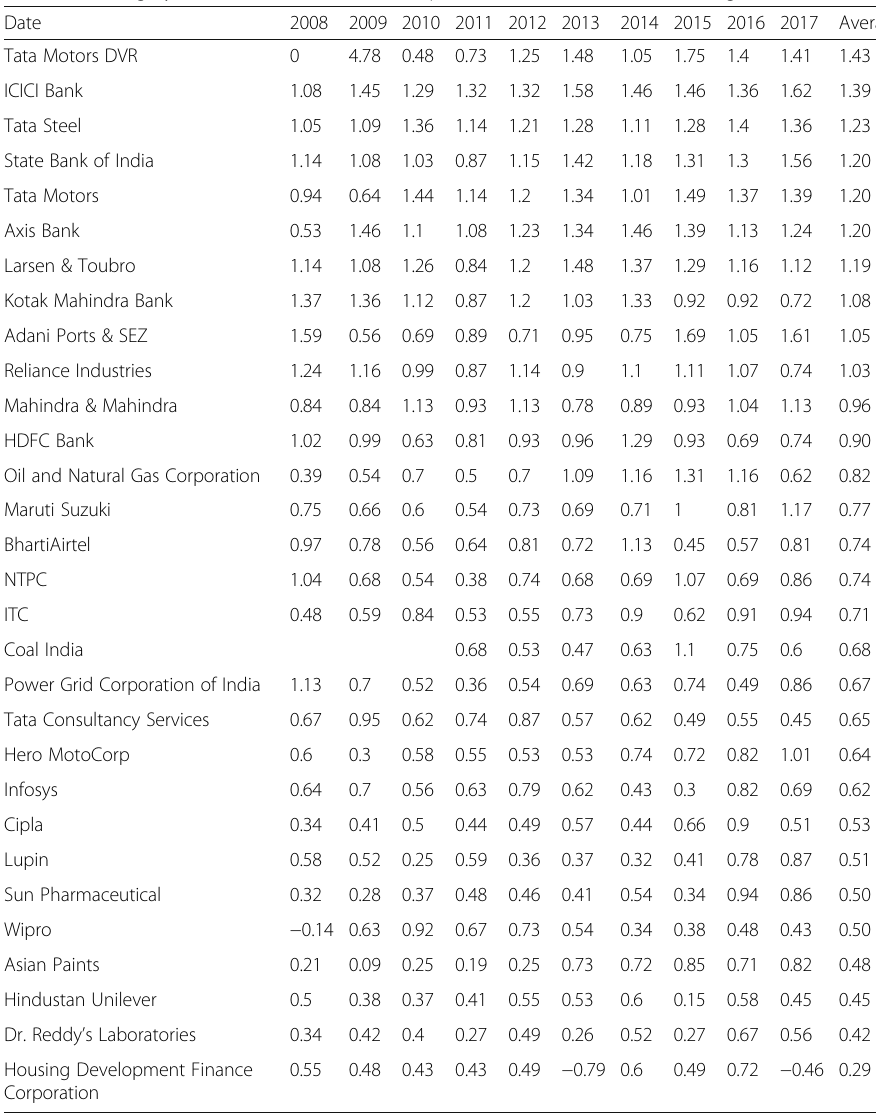
Table 1 Average year-wise beta values of companies listed in BSE Sensex during 2007 –